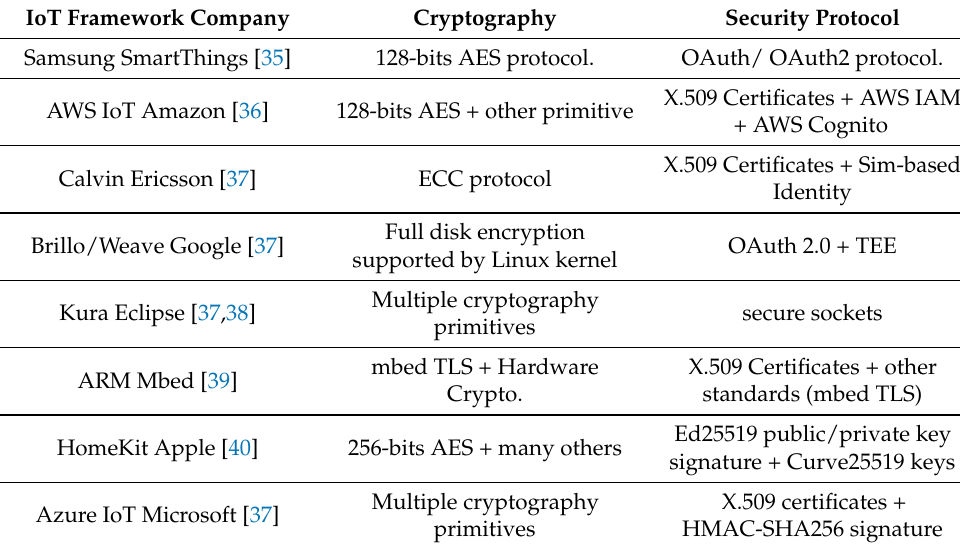
Table 2. A succinct list of the features of IoT